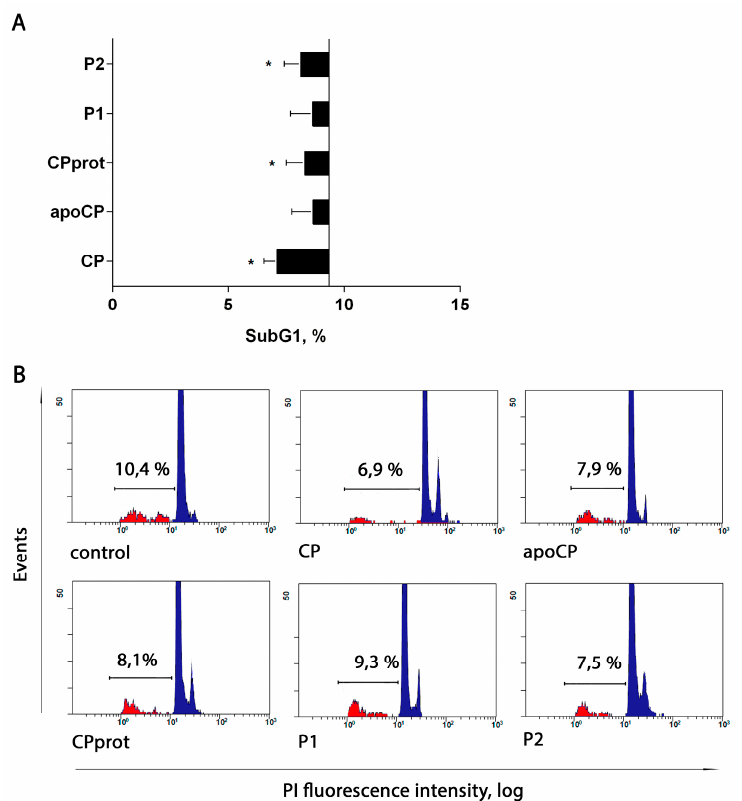
Figure 5. Effect of ceruloplasmin (CP) and its derivatives on spontaneous neutrophil apoptosis. Polymorphonuclear leukocytes (PMNLs; 10 6 /mL) were cultured at 37 ◦ C with 0.5 µ M intact CP, 0.5 µ M apo-CP, 0.5 µ M CPprot (proteolyzed CP), or 20 µ M peptides (P1 or P2) for 20 h and assayed for the proportion Sub G1 PMNLs by flow cytometry. ( A ) Apoptosis levels induced by the indicated compounds. Bars begin at the control line (which corresponds to 9.3 ± 0.77%), values indicate the mean ± SEM of duplicate cultures from six independent experiments; * p < 0.05, compared to control (one-way ANOVA followed by Holm–Š í d á k multiple comparison tests). ( B ) Representative histograms of nuclear DNA fragmentation.